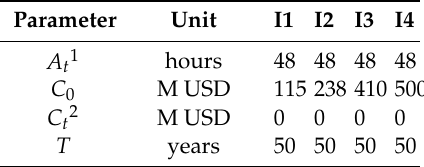
Table 10. Infrastructure NPV